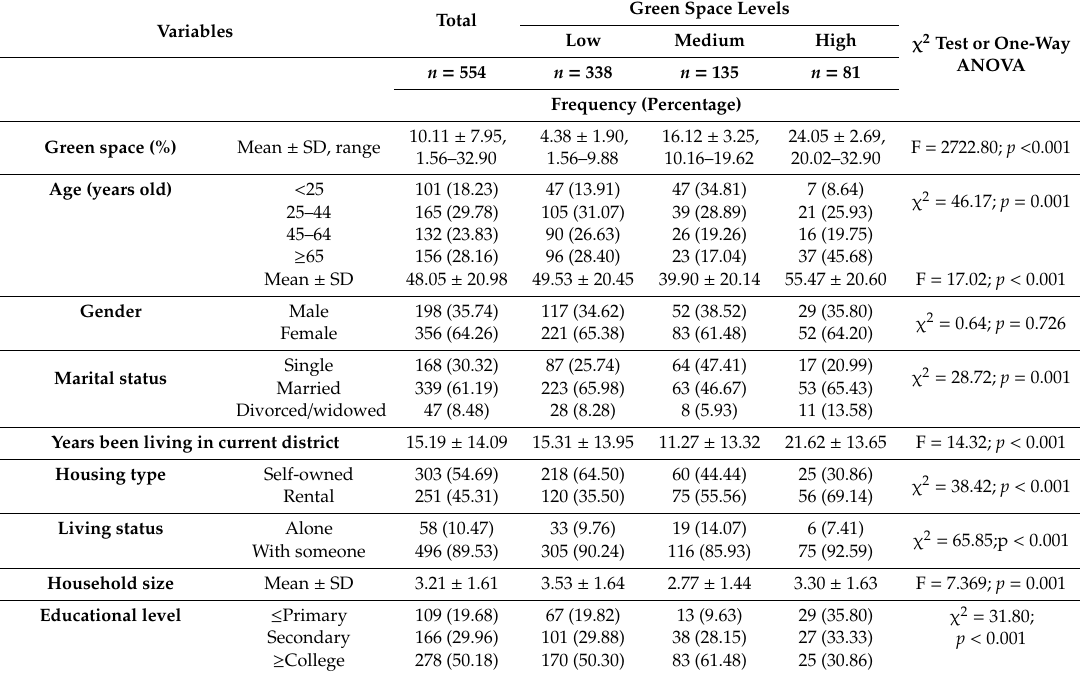
Table 1. Socio-demographic characteristics and quality of life (QoL) scores of participants living with di ff erent green space